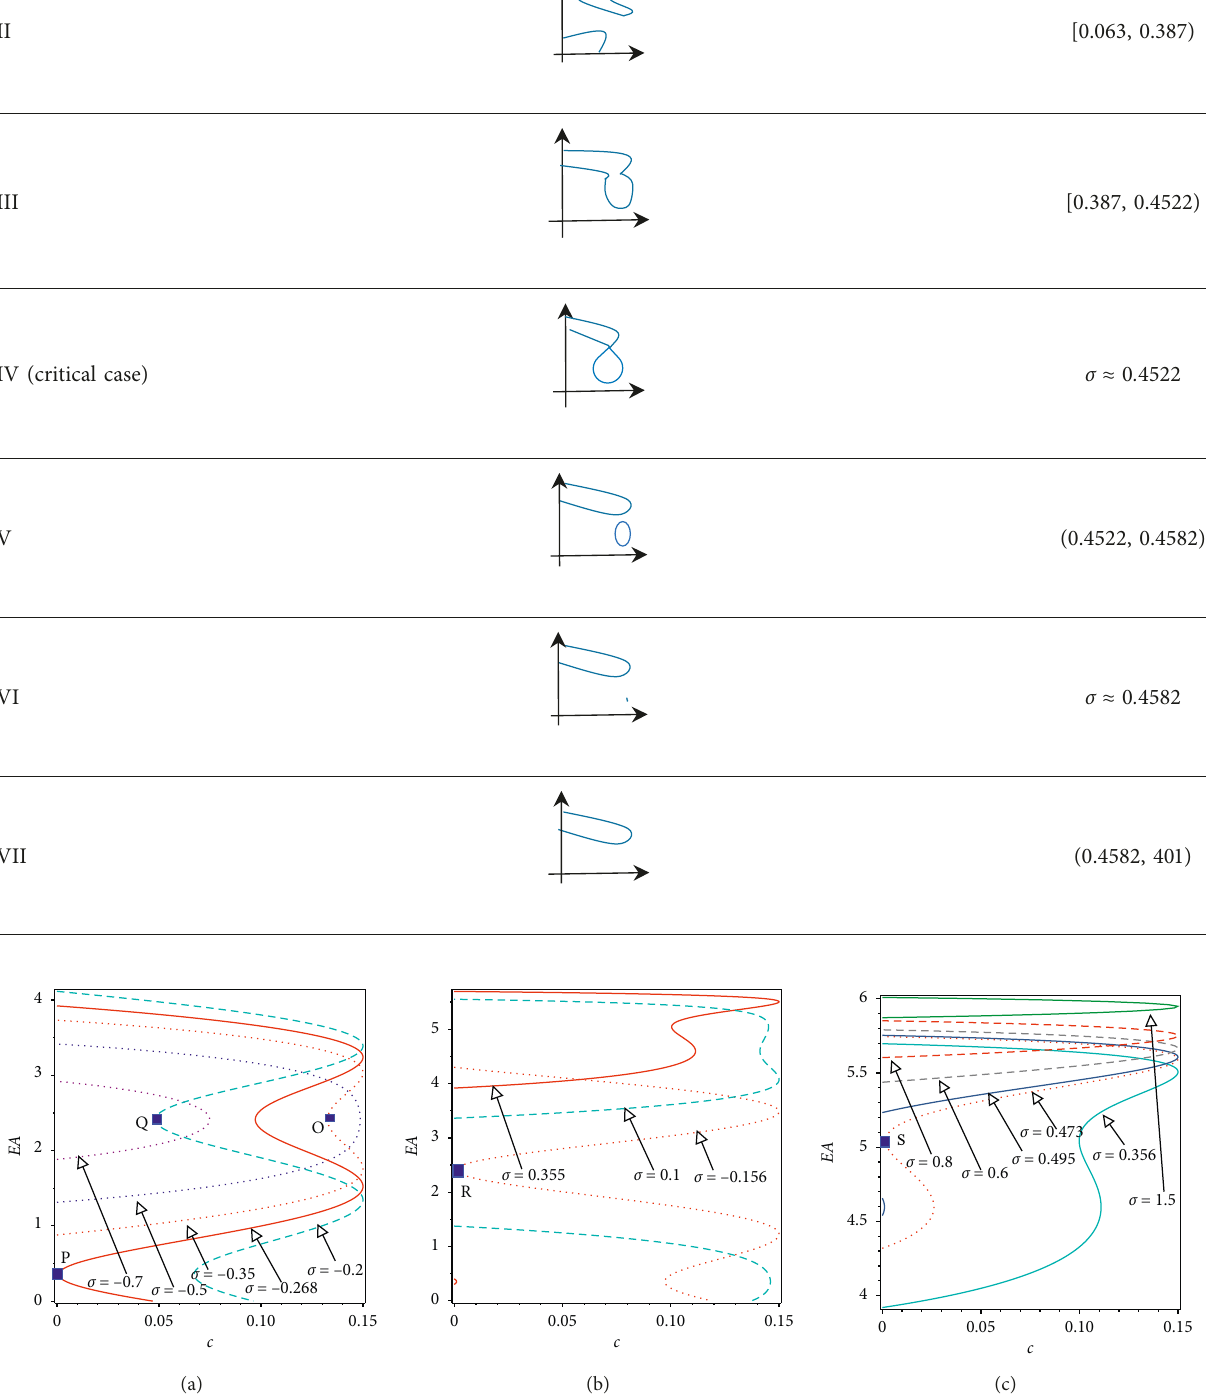
Figure 7: Steady-state moments of the multistable energy harvester under different detuning parameters versus the damping